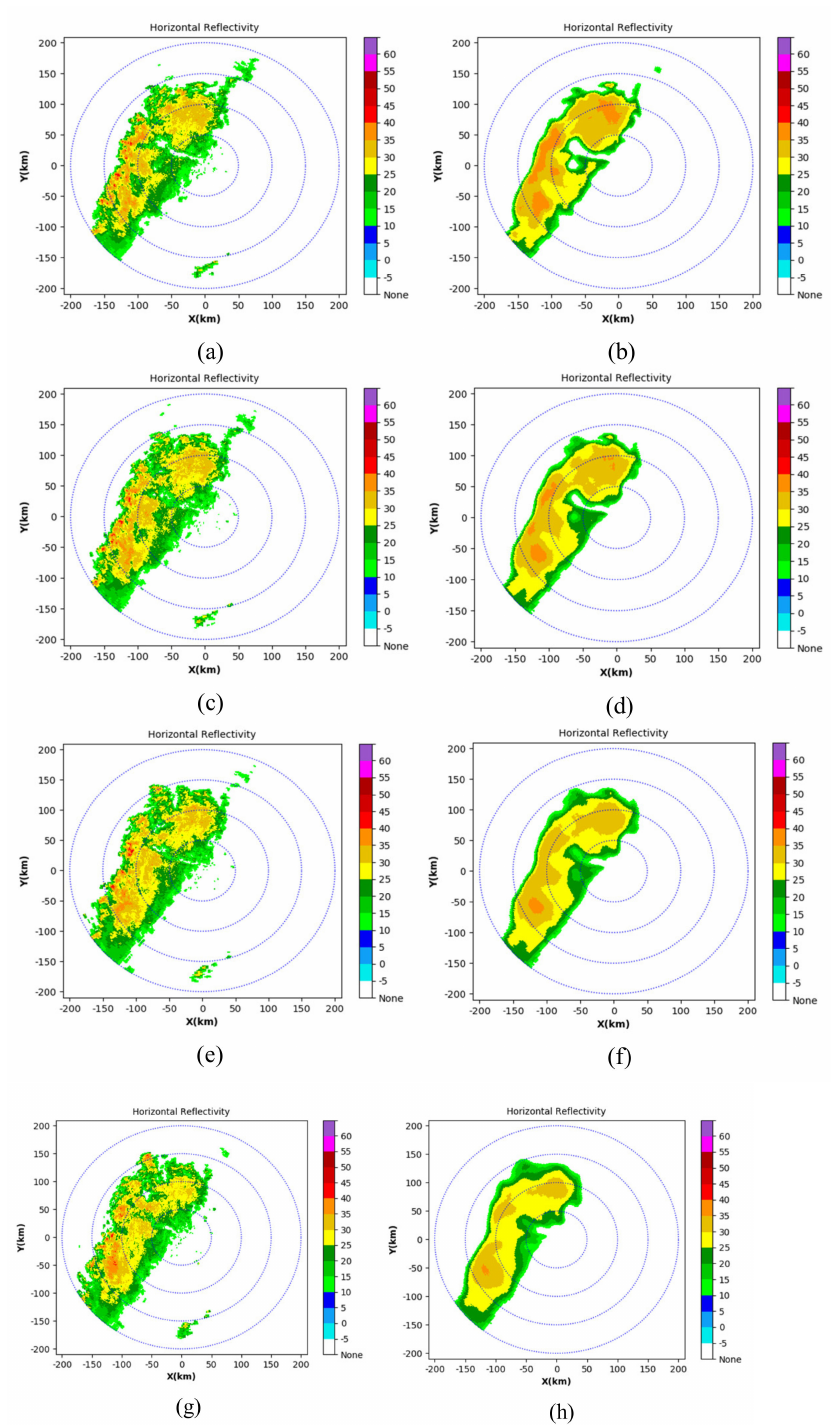
Figure 15. Comparison between extrapolation results and reality at 0.5 h of the deep learning algorithm (( a ) 00:18 reality, ( b ) 00:18 extrapolation, ( c ) 00:30 reality, ( d ) 00:30 extrapolation, ( e ) 00:42 reality, ( f ) 00:42 extrapolation, ( g ) 00:60 reality and ( h ) 00:60